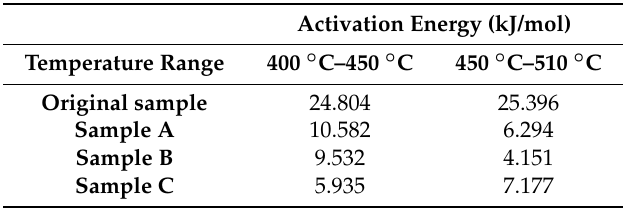
Table 2. Analysis of the activation energy of oil shale and its residue.